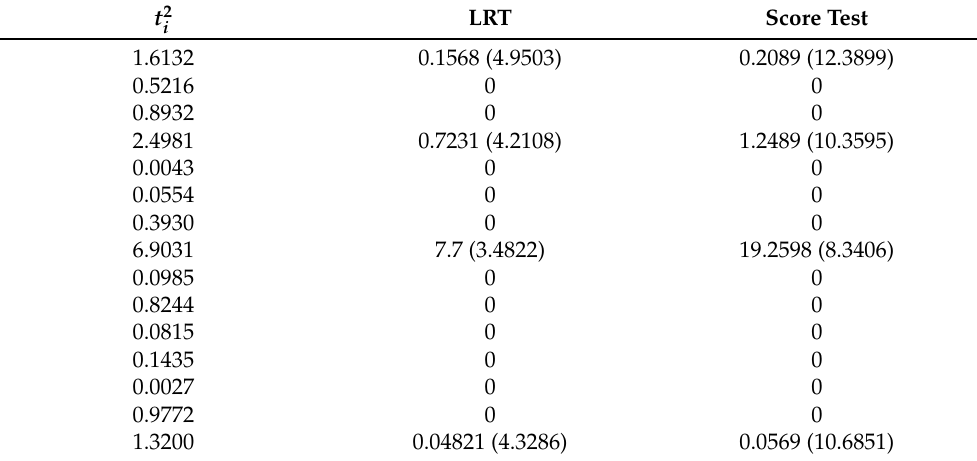
Table 2. Values of t 2 , LR and score test statistics for the fault measurements. Figures in brackets are i 0.01 percentiles of the ED of n first-order statistics under the null hypothesis. n is the number of faulty